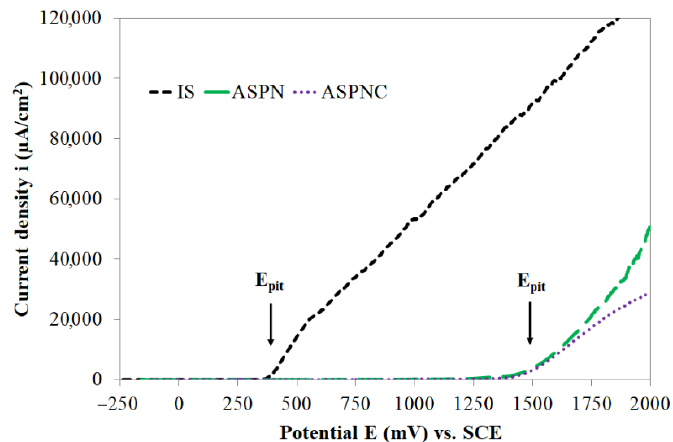
Figure 7. Anodic polarisation curves (up to 2000 mV) of AISI 316L steel in its initial state (IS), after ASPN and ASPNC.